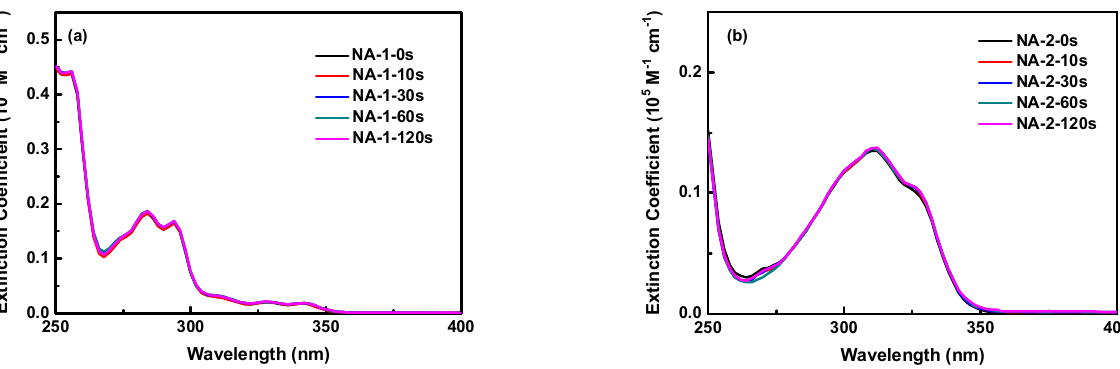
Figure 4. Photolysis of ( a ) NA-1 and ( b ) NA-2 in CH 2 Cl 2 solution at various exposure times (Conc. = 1 × 10 − 5 M).